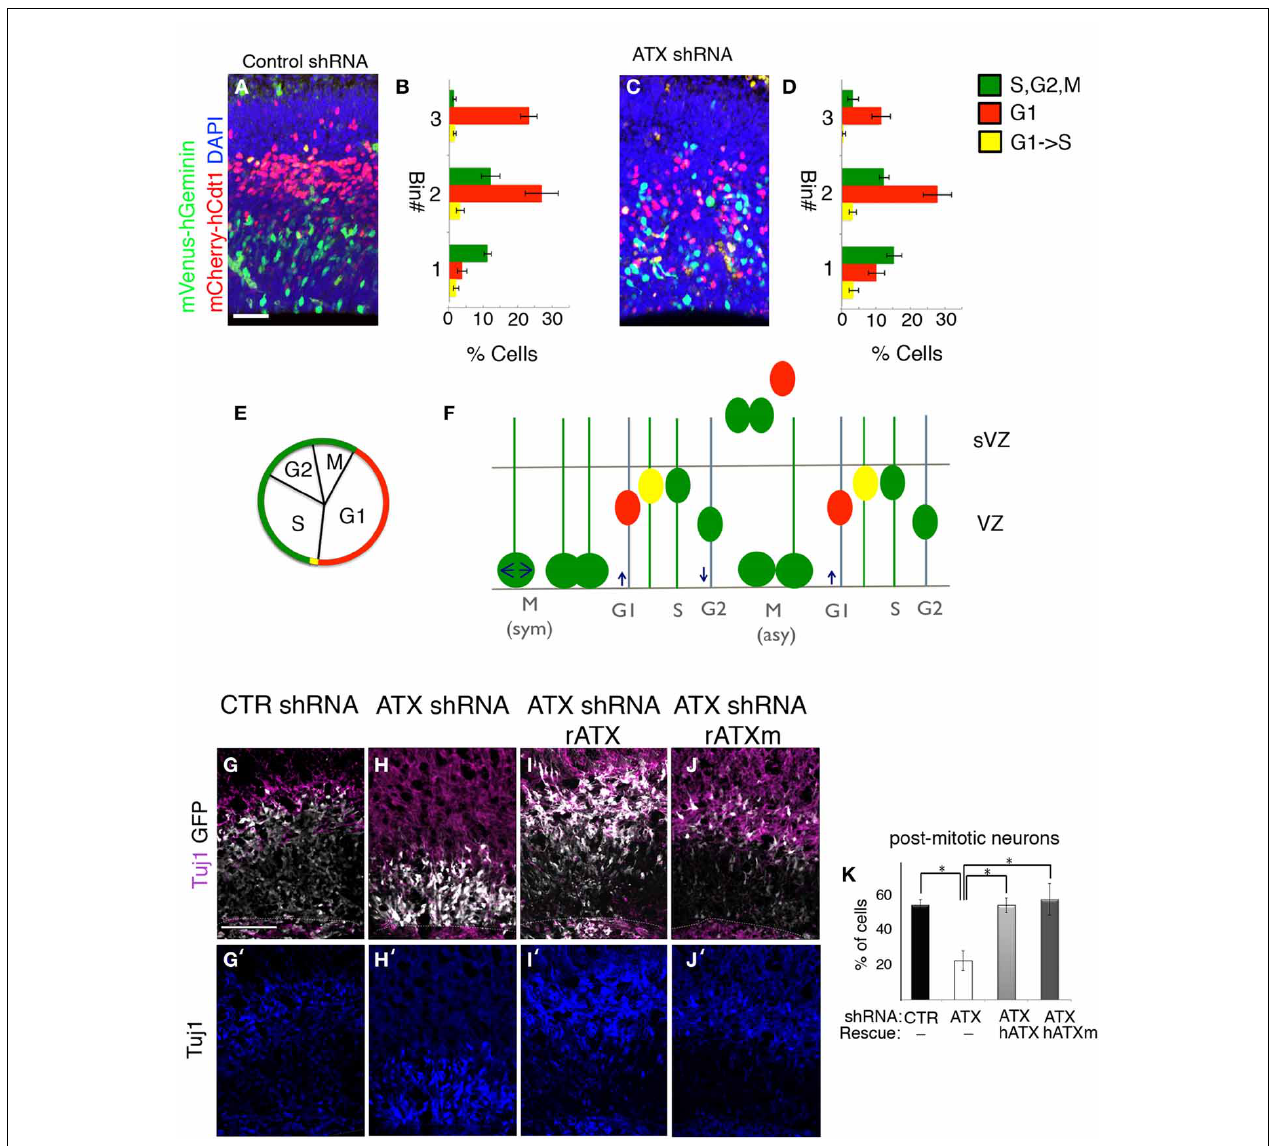
FIGURE 8 | ATX knock down interferes with progenitors differentiation. (A–D) Fucci markers (mCherry-hCtd1,mVenus-hGeminin) were electroprated at E13 with control (A,B) or ATX shRNA (C,D) . Brains were analyzed 24h later. The location of red cells (G1) Green cells (S,G2,M) and yellow cells (G1- > S) was recorded in three arbitrary bins along the width of the cortex. (E) Cell cycle correlates with FUCCI markers expression. (F) Interkinetic nuclear movement in the ventricular zone (VZ), and cell exiting to the subventricular zone (sVZ) would accumulate the